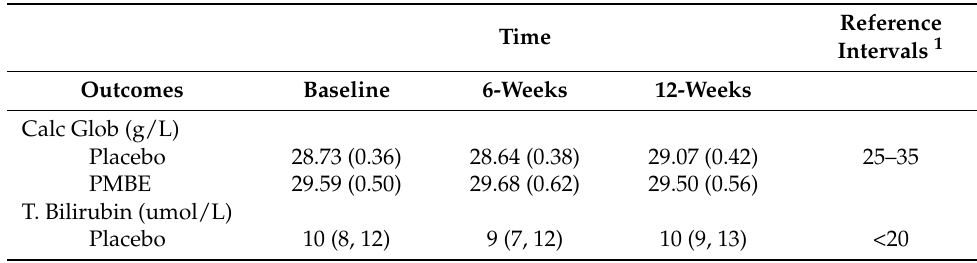
Table 5. Liver function parameters at baseline, 6 weeks and post-intervention in the placebo and PMBE groups.